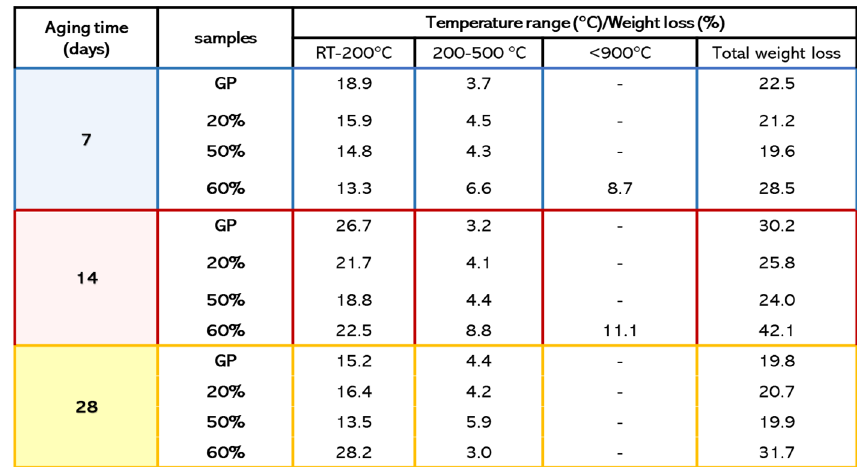
Figure 10. TGA data summary of the samples extracted after different curing